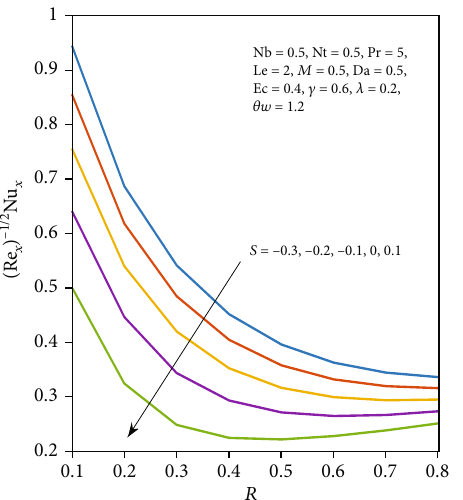
ffiffiffiffiffiffiffi p Nu / Re for values of M x x